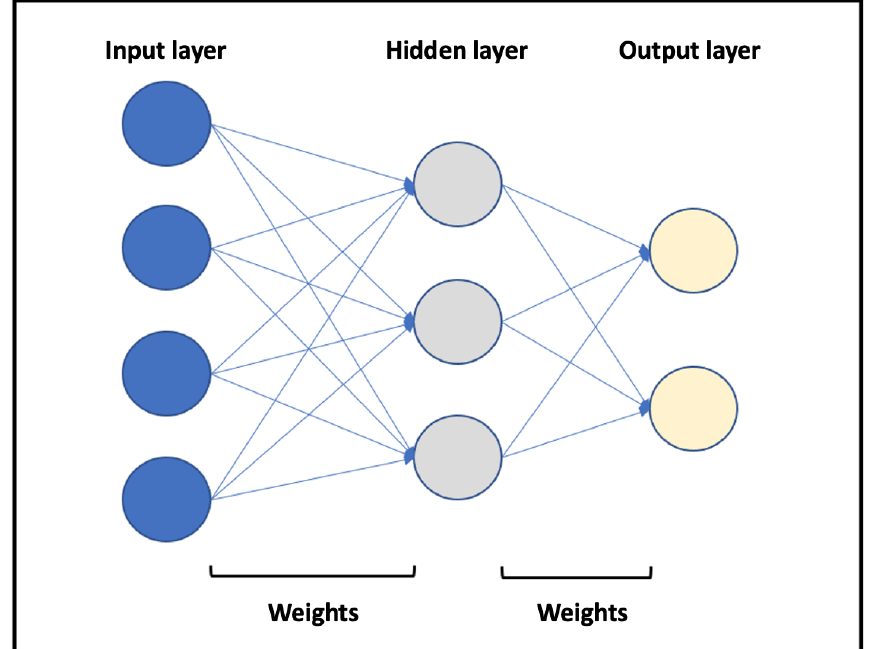
Figure 2. Representation of a basic neural network. Different layers are represented in blue (input layer), gray (hidden layer), and yellow (output layer). The arrows represent the relationships between neurons (weights).